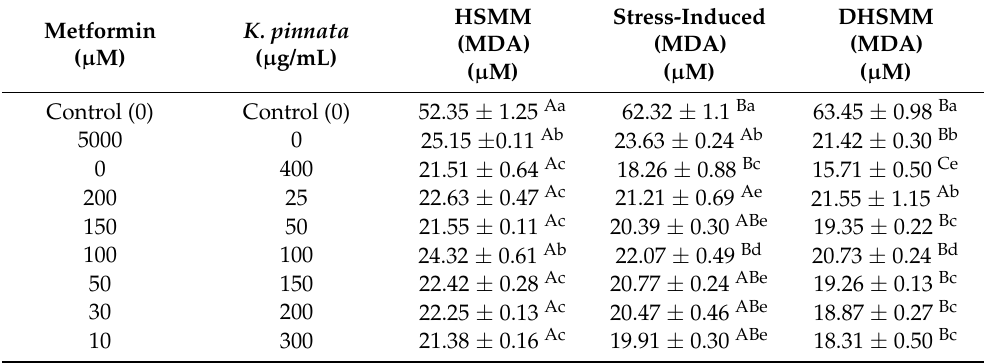
Table 7. Cellular MDA concentrations in cells after 72 h of treatment. Data are presented as mean ± standard error of the mean. Significant differences are indicated by different letters (upper- case letters within row; lowercase letter within column for each treatment option) according to Tukey post hoc test ( p < 0.05). Control (No treatment); Human skeletal muscle myoblast (HSMM); Diabetic human skeletal muscle myoblast (DHSMM).